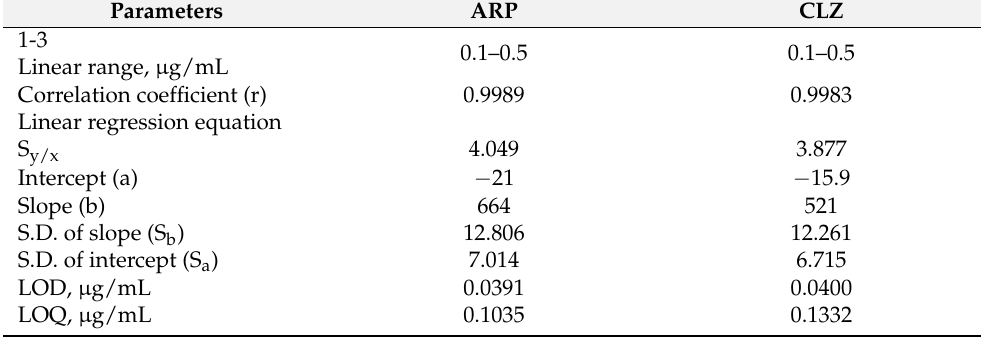
Table 1. Analytical parameters for spectrofluorometric assessment of aripiprazole and clozapine.